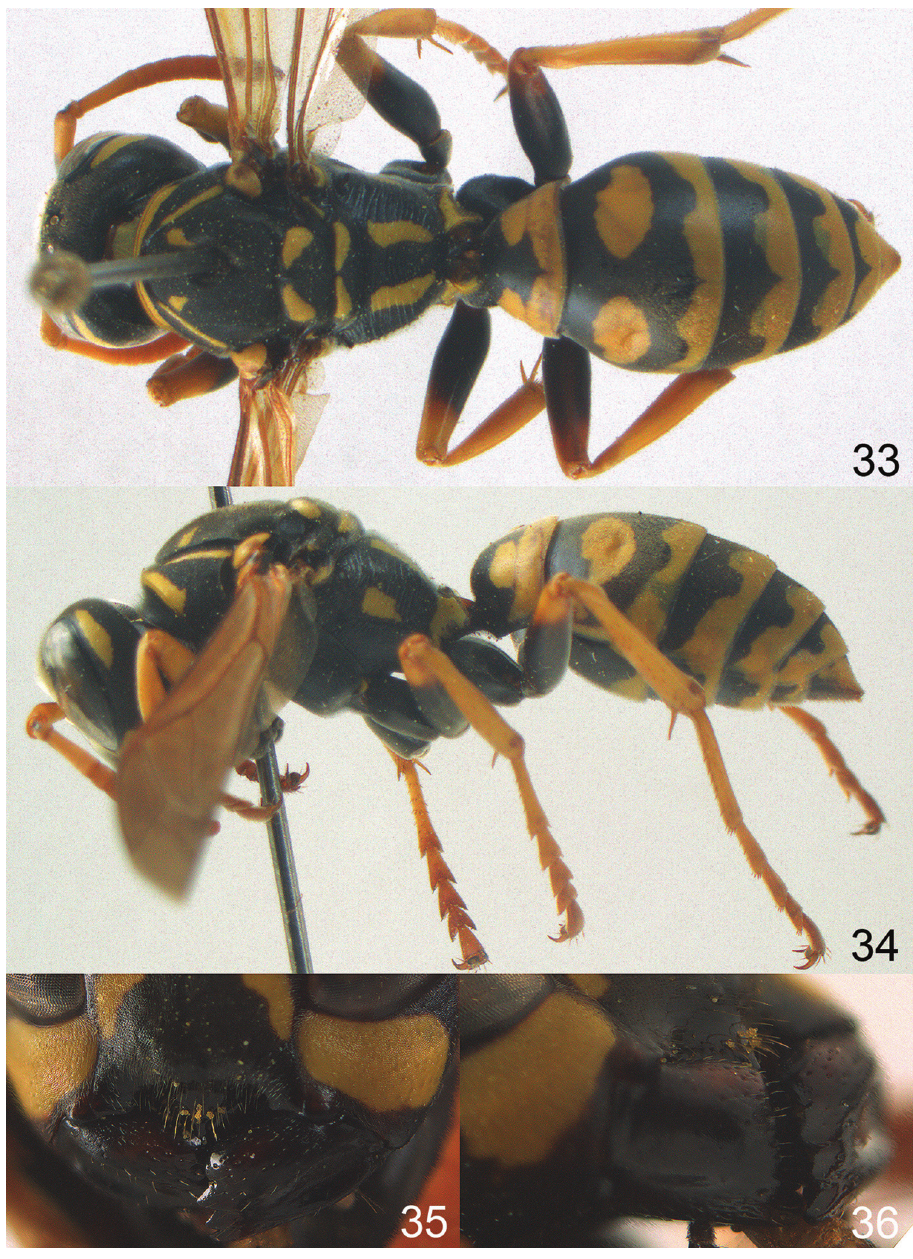
Figures 33–36. Polistes austroccidentalis sp. n. Holotype female. 33 Habitus, dorsal view 34 habitus lateral view 35 lower part of head in frontal view 36 gena and